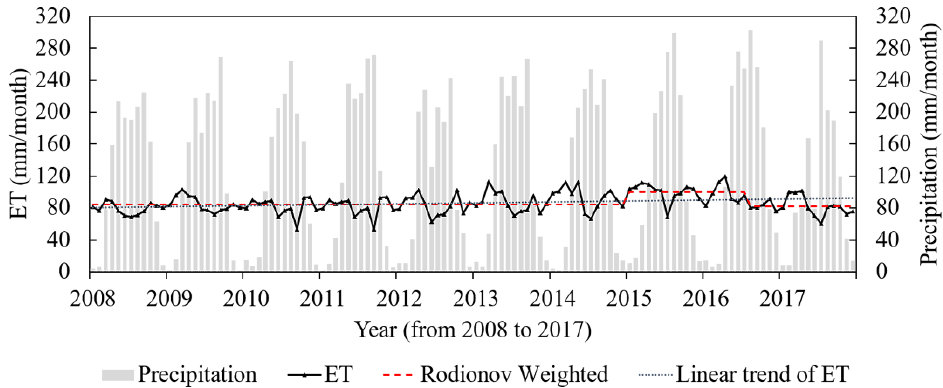
Figure 3. Overall variation trends of monthly ET and monthly precipitation from 2008 to 2017 with the Rodionov weighted line.